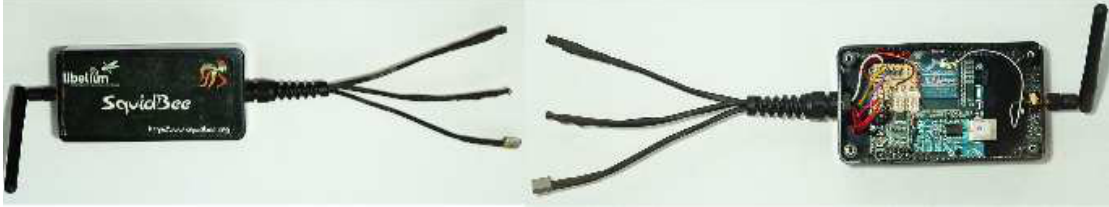
Figure 2. External and internal view of a SquidBee